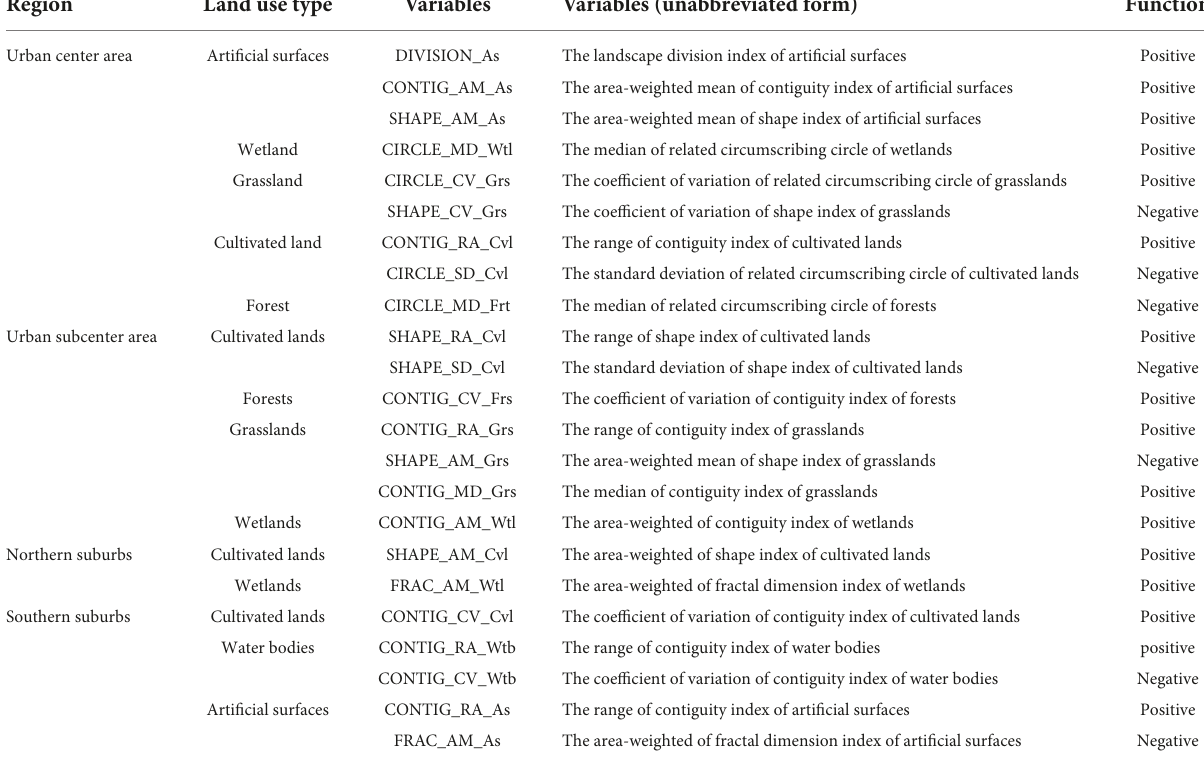
TABLE 9 Leading landscape patterns of each region derived by multiple regression